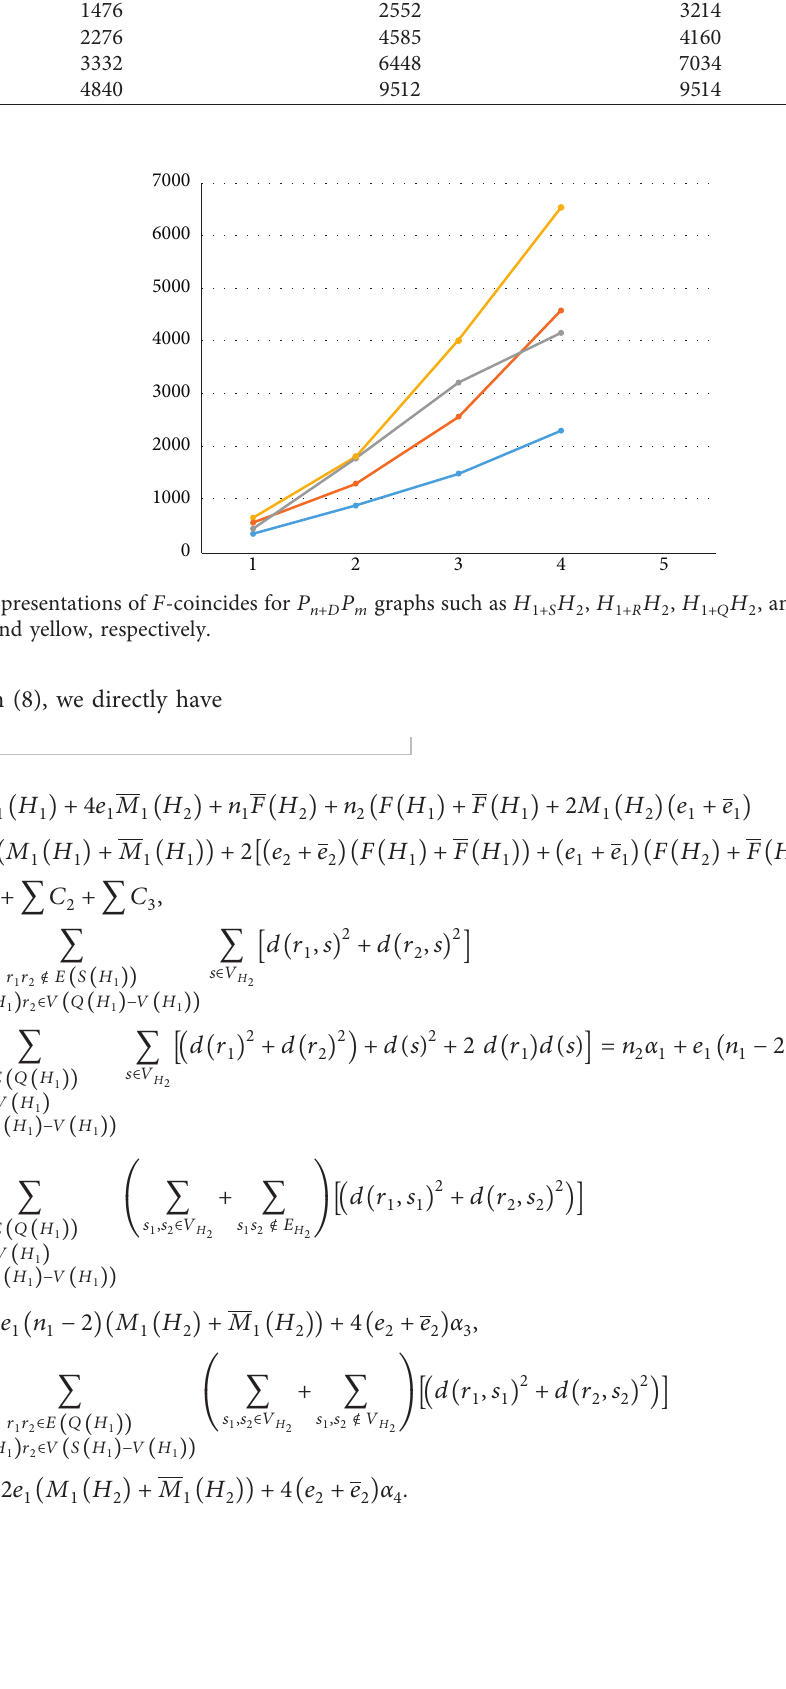
D -sum graphs by taking different values for n and m .